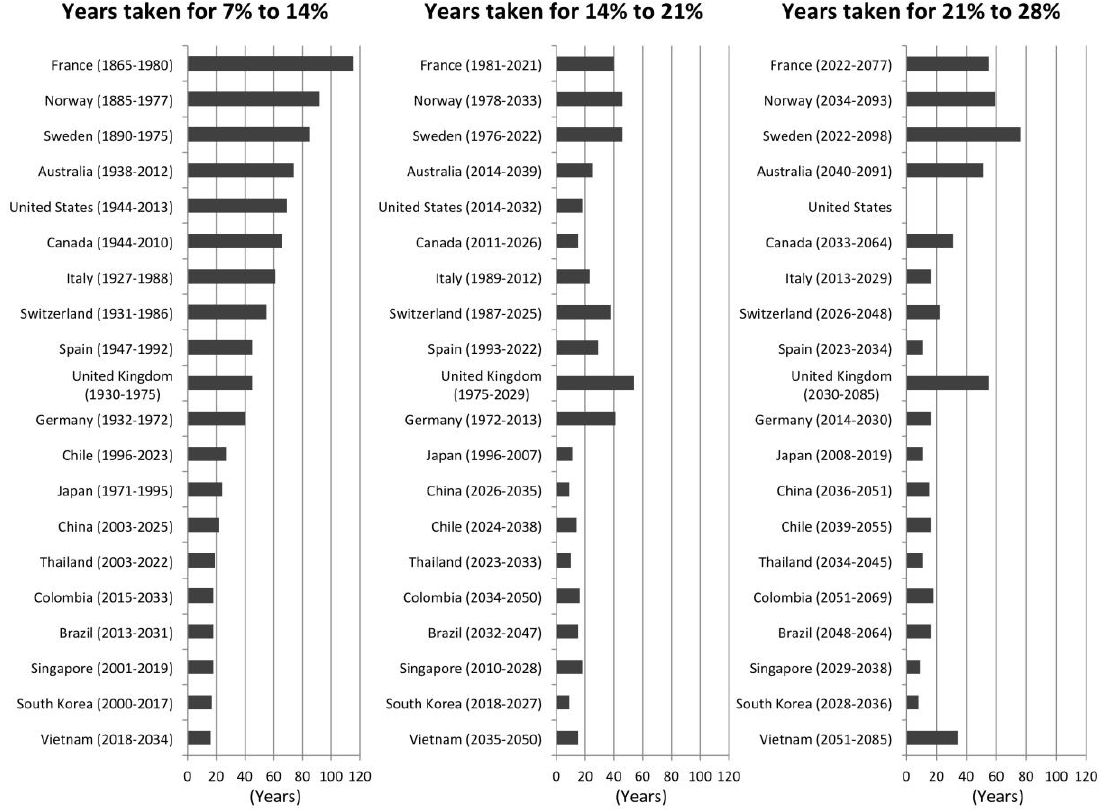
Figure 5. Number of years taken or predicted to take for three aging transitions in selected countries. Note: Created from the Organisation for Economic Co-Operation and Development (OECD) and UN demographic database. Years in parentheses are the periods during which each aging transition occurred or is predicted to occur.